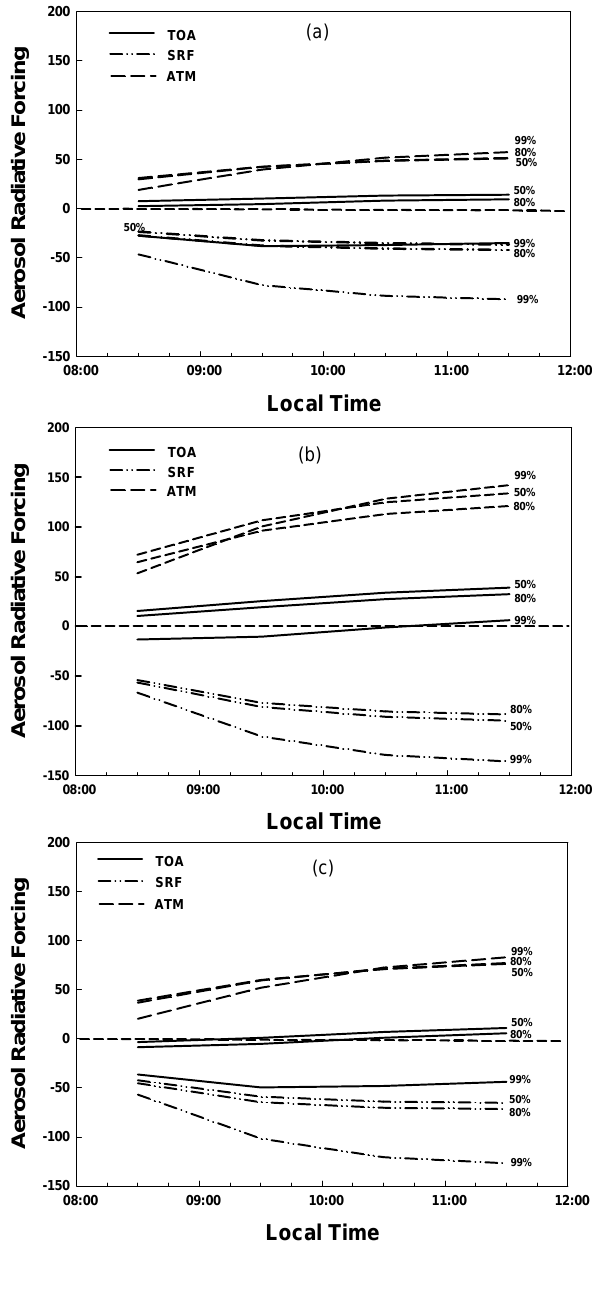
Fig. 9. Aerosol radiative forcing for 99%, 80% and 50% RH val- ues, at the top of the atmosphere (TOA), at the surface (SRF) and within the atmosphere (ATM) for (a) “before fog” days, 8 Decem- ber (b) during foggy day, 13 December and (c) after foggy days, 17